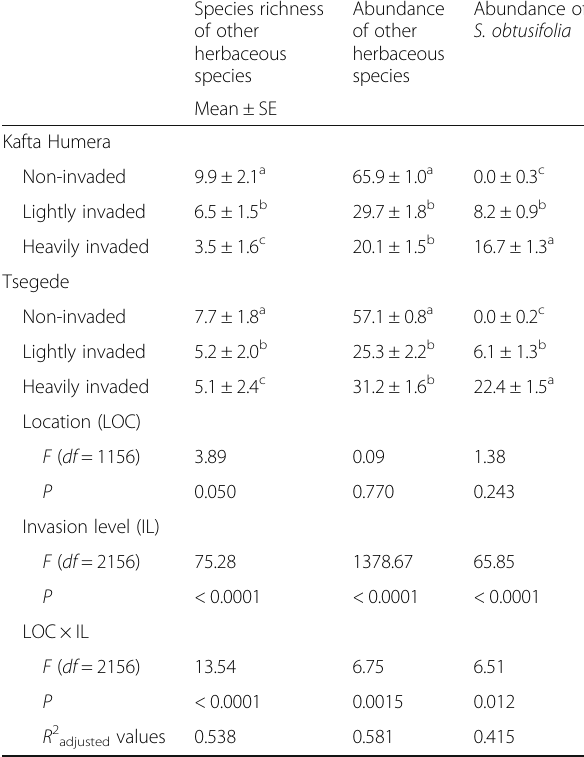
Table 2 Species richness (number of species m − 2 ) and absolute abundance (numbers in m − 2 ) of herbaceous vegetation and bare ground (%) under three invasion levels of Senna obtusifolia (L.) (non-invaded, lightly invaded, and heavily invaded) at two locations in northern Ethiopia, with statistical results of the